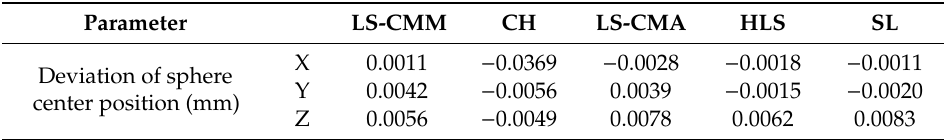
Table 2. Average deviation of the sphere’s center position according to the X, Y, and Z axes of the optical measurements from reference values